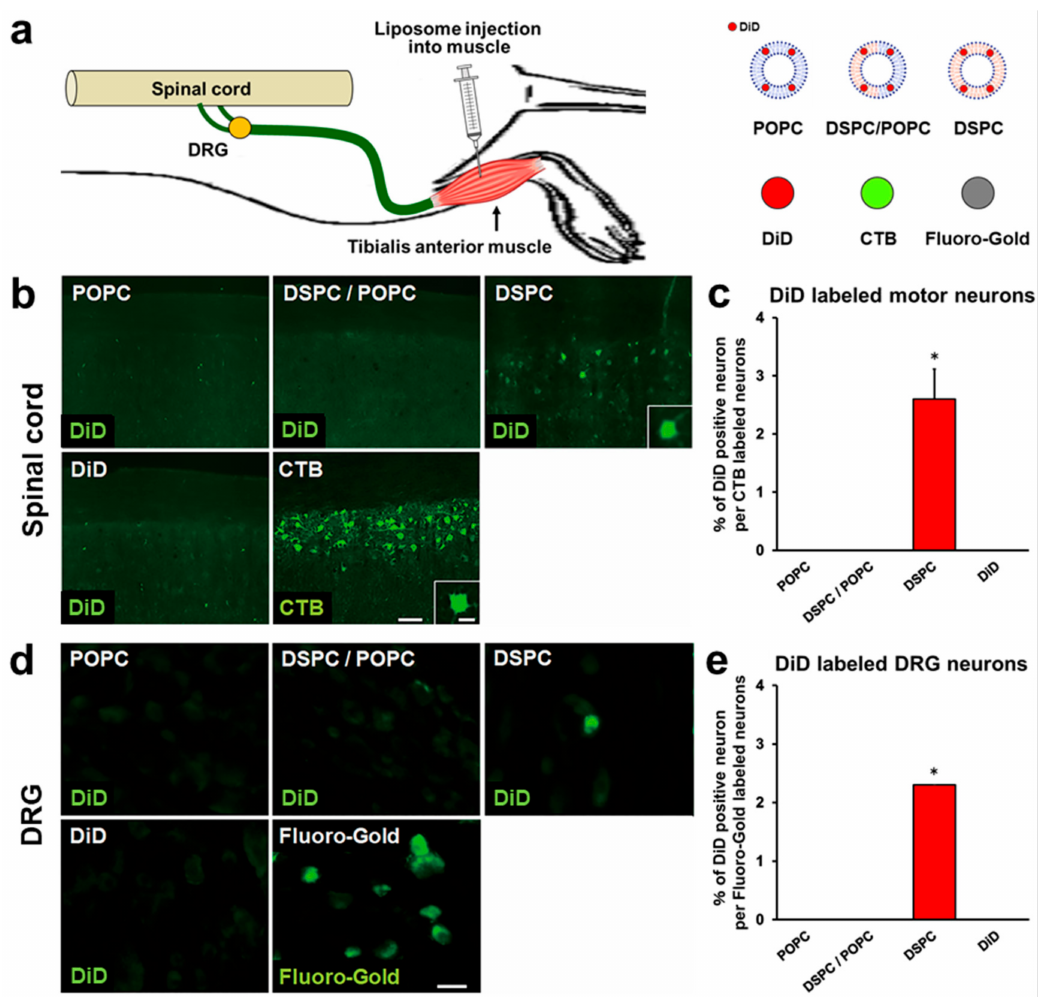
Figure 3. Retrograde transport of liposomes consisting of different phospholipids to spinal cord motor neurons and DRG neurons 3 days after tibialis anterior injection. ( a ) Schematic overview of tibialis anterior injection. ( b ) Horizontal sections of the lumbar spinal cord. Rostral is left. Motor neurons receiving retrogradely transported liposomes were identified by DiD fluorescence. Insets are high-magnification views of DiD-labeled motor neurons. Only DSPC liposomes were identified